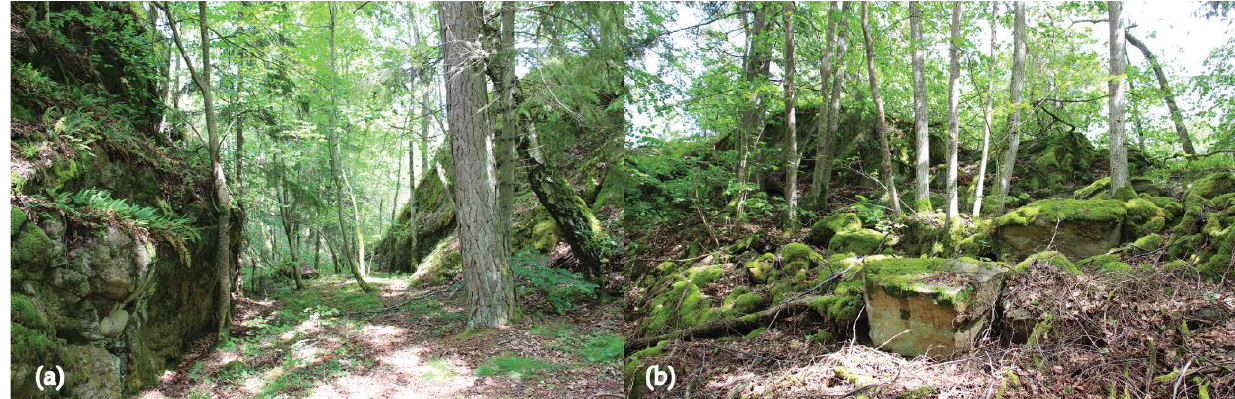
Figure 2. Studied forest in Eastern Norway; ( a ) rocks and ( b ) large stones on ground make this type of forest less attractive for forestry use.